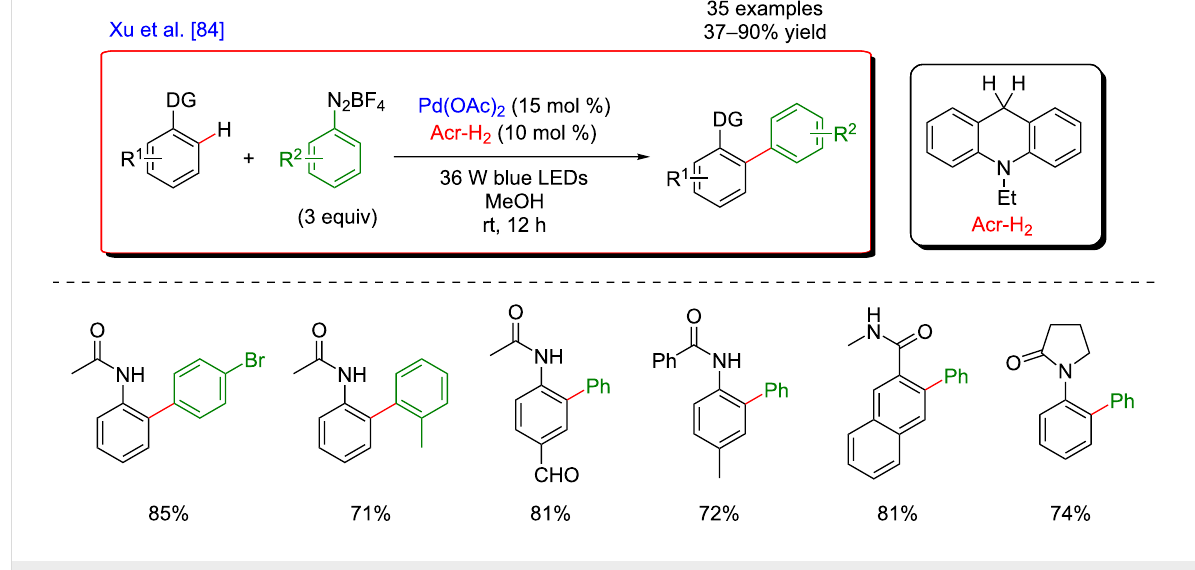
Figure 23: Direct arylation via the dual catalytic system reported by Xu.